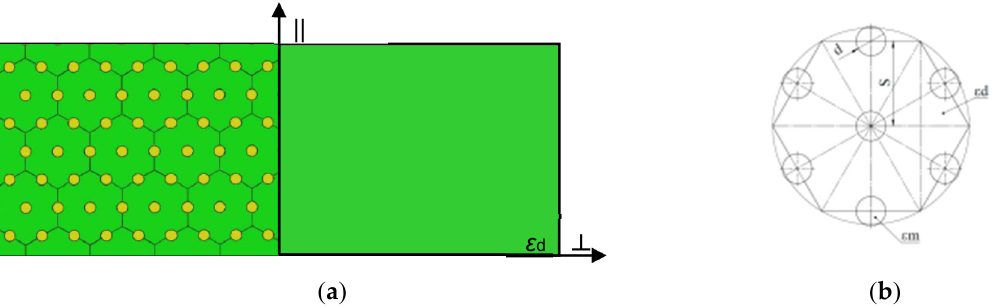
Figure 1. A view of the boundary, splitting up the nanowire composite and dielectric medium ( a ); a hexagonal unit cell ( b ).